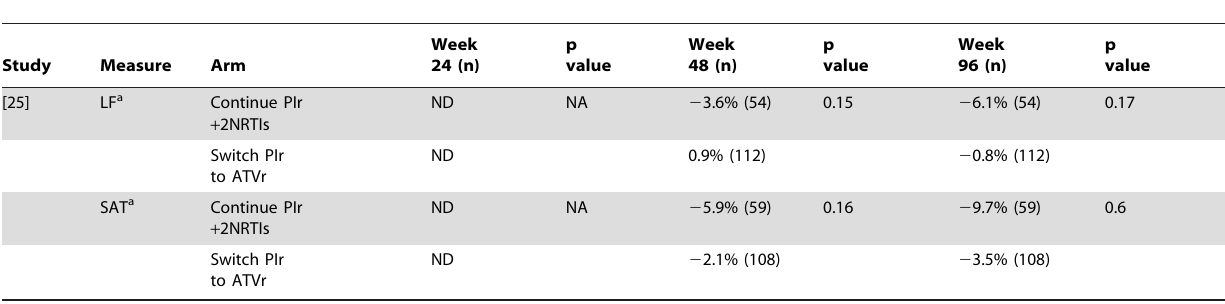
Table 20. Switching studies: change from baseline in limb fat (LF) on DEXA scan and subcutaneous adipose tissue (SAT) on CT scan: PI versus PI.